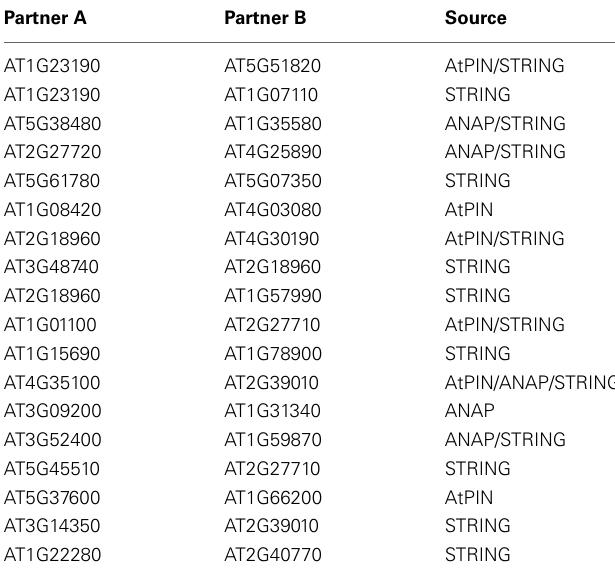
Table 4 | Common interactions between the reconstructed network and online PIN